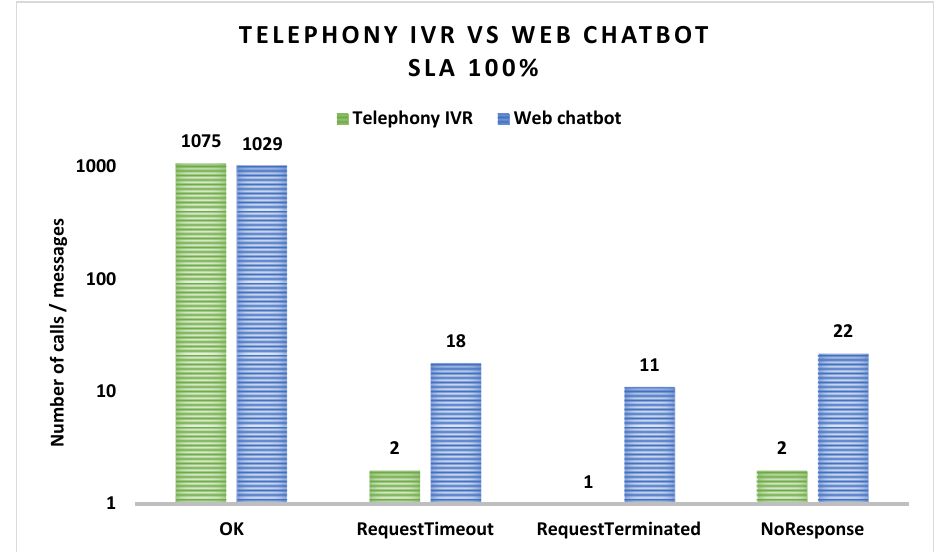
Figure 6. SLA compliance evaluation of the PoCs.